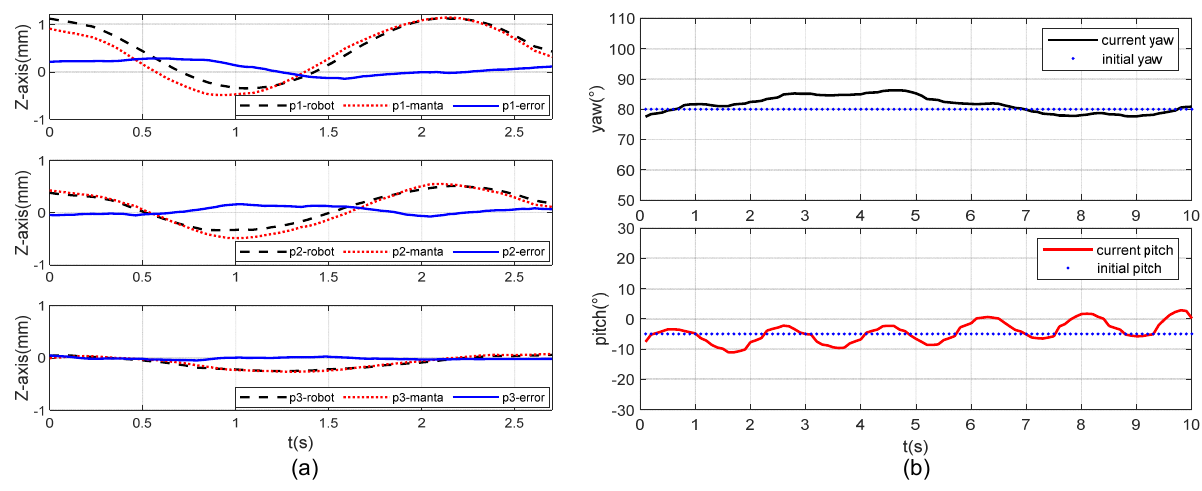
Figure 12. ( a ) Motion sequence diagram of manta robot with the pectoral fin feature points of manta ray; ( b ) Performance of forward swimming (after optimization). Table 3. Comparison of similarity values before and after optimization.